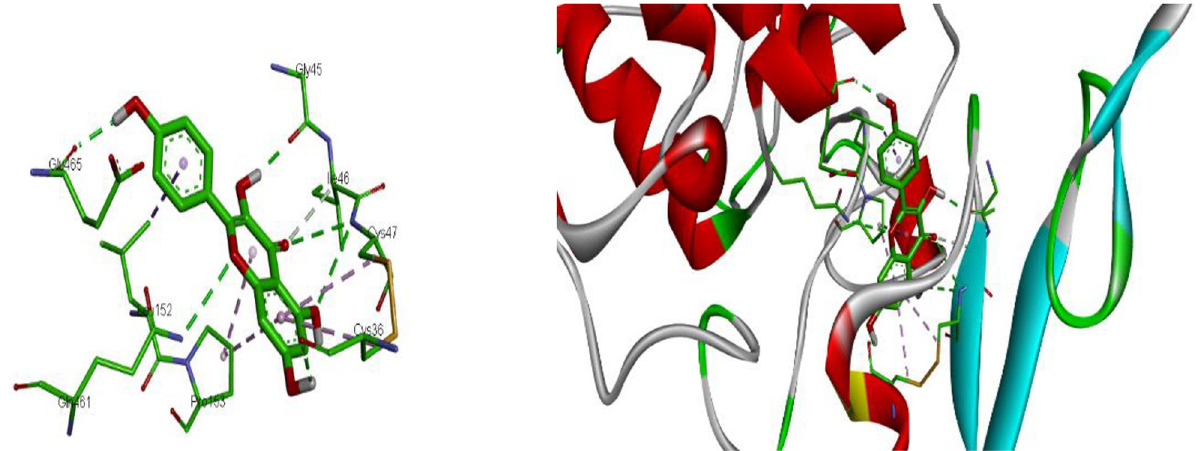
Fig 10. 2D and 3D representations of the interaction of kaempferol with COX-1 (PDB ID: 3N8Y). https://doi.org/10.6084/m9.figshare.21828969. v1.